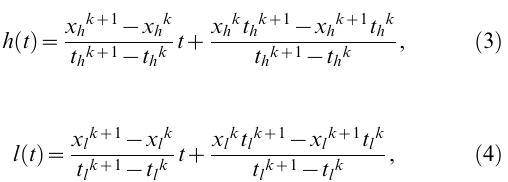
Figure S3 Dependence of spatial phase-fluctuation on the natural frequency of pacemaker. (a) Phase patterns on the surface of SCN (z = 0) with c =0. The pacemaker is located on the x =0 plane, where oscillation frequency of the cells is 4% (upper panels) or 2.7% (lower panels) faster than that of the neurons in the other regions. The color map is the same as in Fig. 3b. (b) D as a function of K , when the oscillation frequency of pacemaker is 4% (closed circles) and 2.7% (open squares) faster than that of the neurons in the other regions. The parameters were set as N L = 10 and s v = 0.05. (TIF) Video S1 This animated movie shows the spatiotemporal variation of bioluminescence x and the phase h , amplitude A on the right side of the cultured SCN slice as shown in Fig. S1a for t = 30 h to136 h. The phase wave with the discontinuous wave front propagated from the dmSCN to the vlSCN. The innermost dmSCN region, in which the Per2 oscillation is initiated, does not correspond to the area with the maximum oscillation amplitude. Instead, the area with the maximum amplitude was located at the center of the